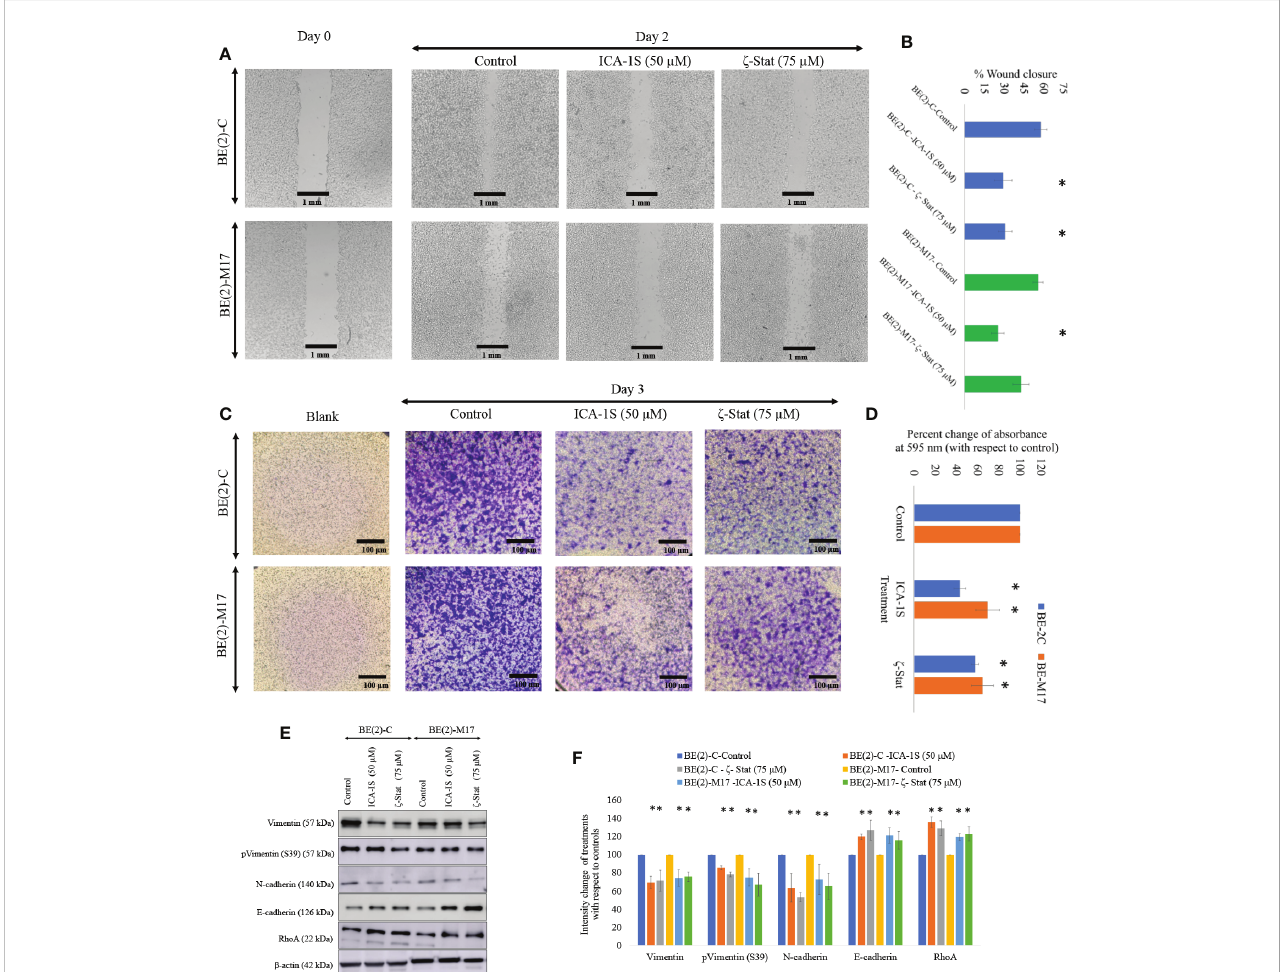
FIGURE 4 Inhibitors decrease NB cellular migration and invasion. (A) The effect of aPKC inhibitors (50 µM of ICA-1S and 75 m M of z -Stat) on NB cell migration in the wound healing assay. Microscopic photographs (40x) of scratches on cells at the beginning (day 0) were compared with the photographs taken after 2